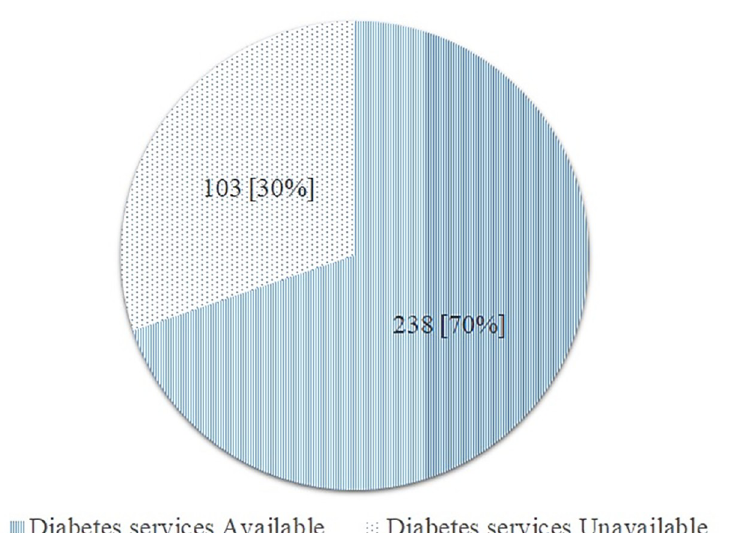
Fig 2. Percentage of tuberculosis facilities with available diabetes services [N =